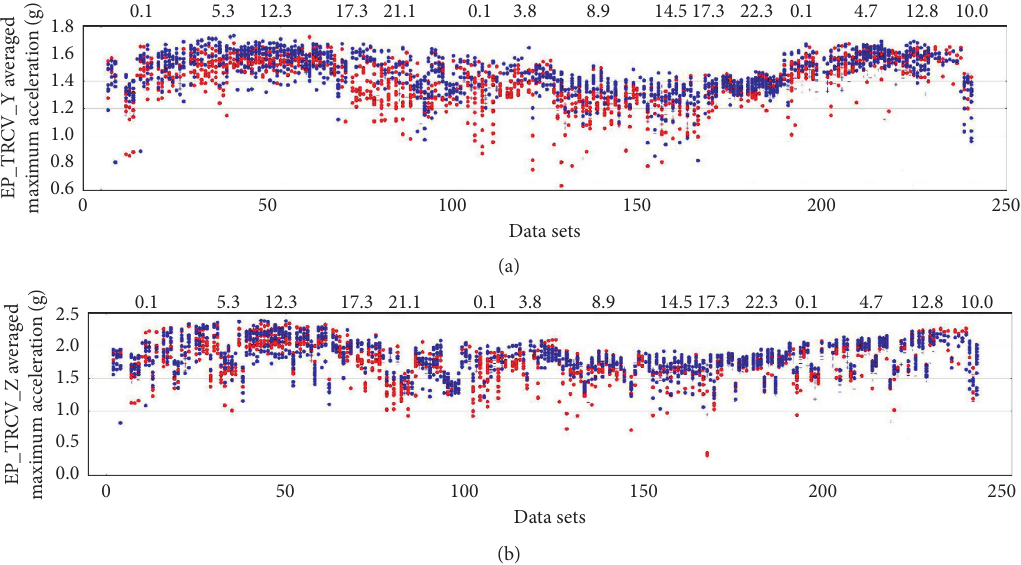
Figure 9: Unfiltered acceleration on CBSE traction transformer in (a) lateral and (b) vertical